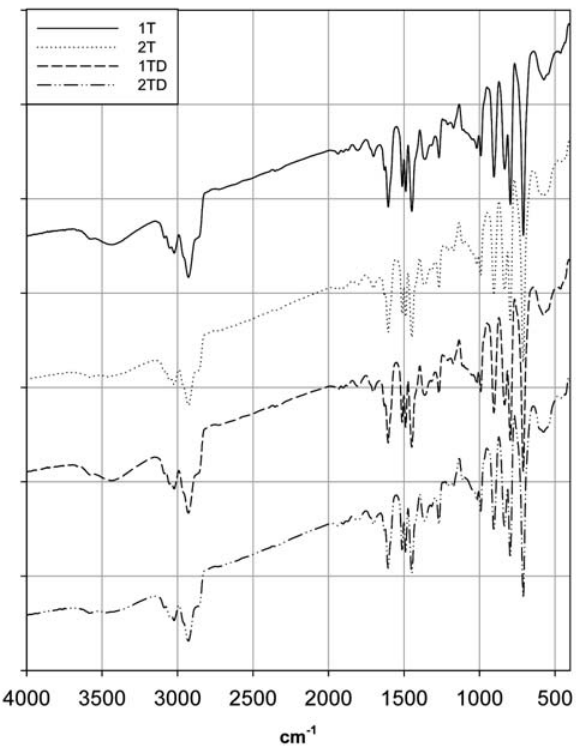
Figure 2. Recorded FT-IR spectra of the resins 1T, 2T, 1TD and